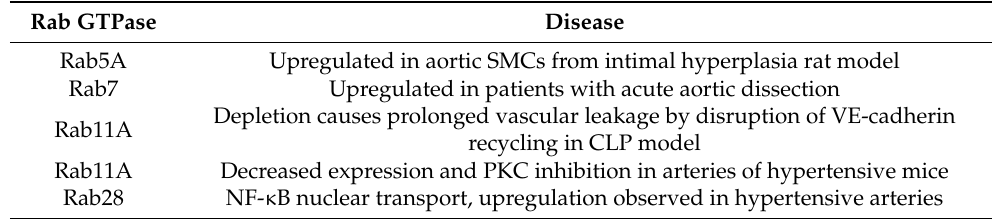
Table 3. Rab GTPases function uncovered from in vivo